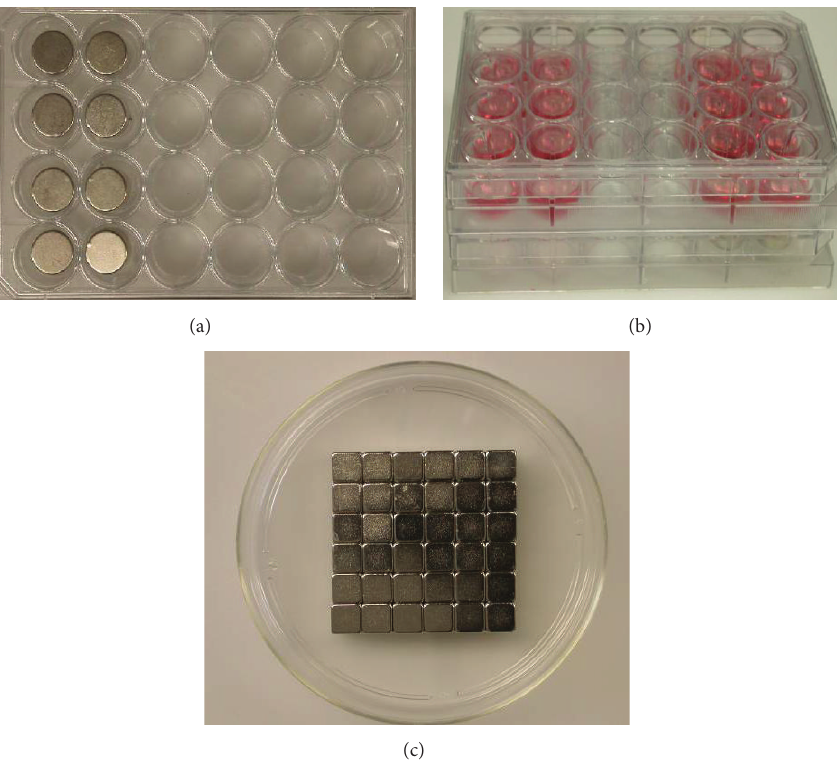
Figure 1: 0.5 T SMF exposure system. (a) Eight circular magnets were embedded in the wells of the first and second columns on the 24- or 96-well plates. (b) The magnet-embedded plates were placed firmly at the bottom of the cell-cultured ones in a well-to-well fashion. (c) Cubic magnets were positioned below a Petri